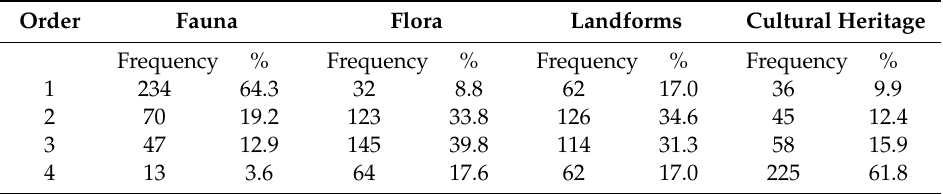
Table 4. Preferential ordering in responses to questions WP1 (Section WP, question 1) and WP2 (Section WP, question